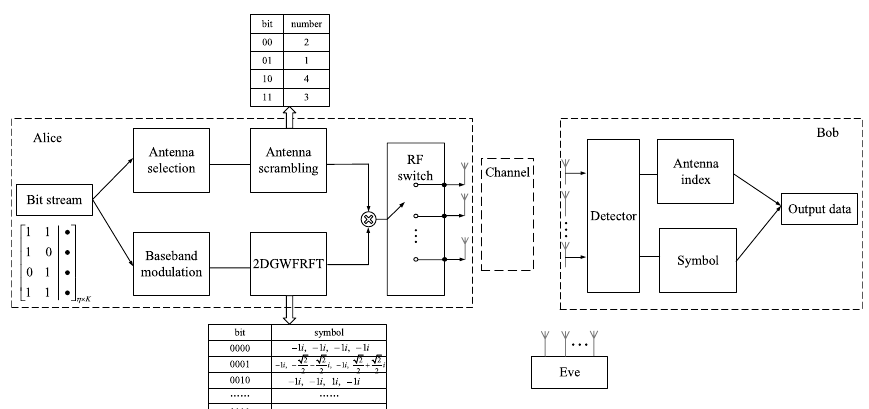
Fig. 1 Basic structure of the proposed system